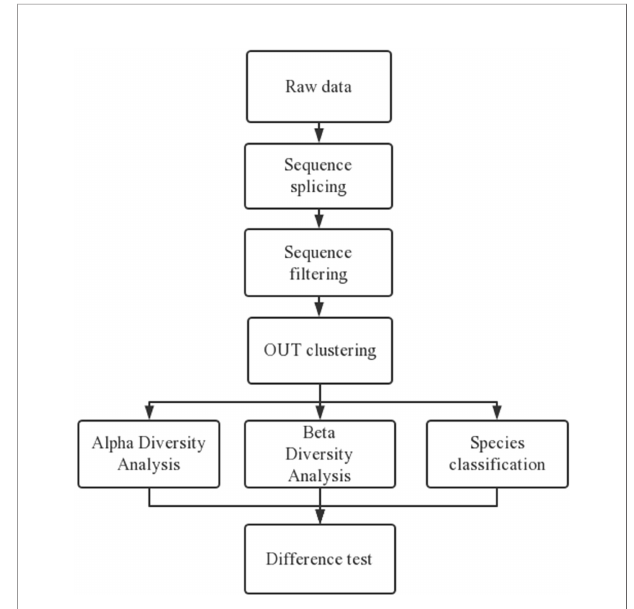
FIGURE 2 | Speci fi c 16S rRNA analysis steps.